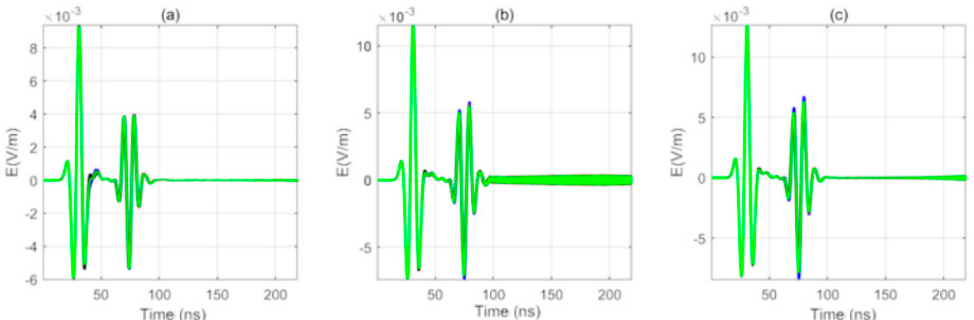
Figure 13. Received signals for borehole fluid with different dielectric constants (blue: the east antenna; black: the west antenna; red: the south antenna, green: the north antenna); ( a ) the dielectric constant is 11, ( b ) the dielectric constant is 41, and ( c ) the dielectric constant is 71.